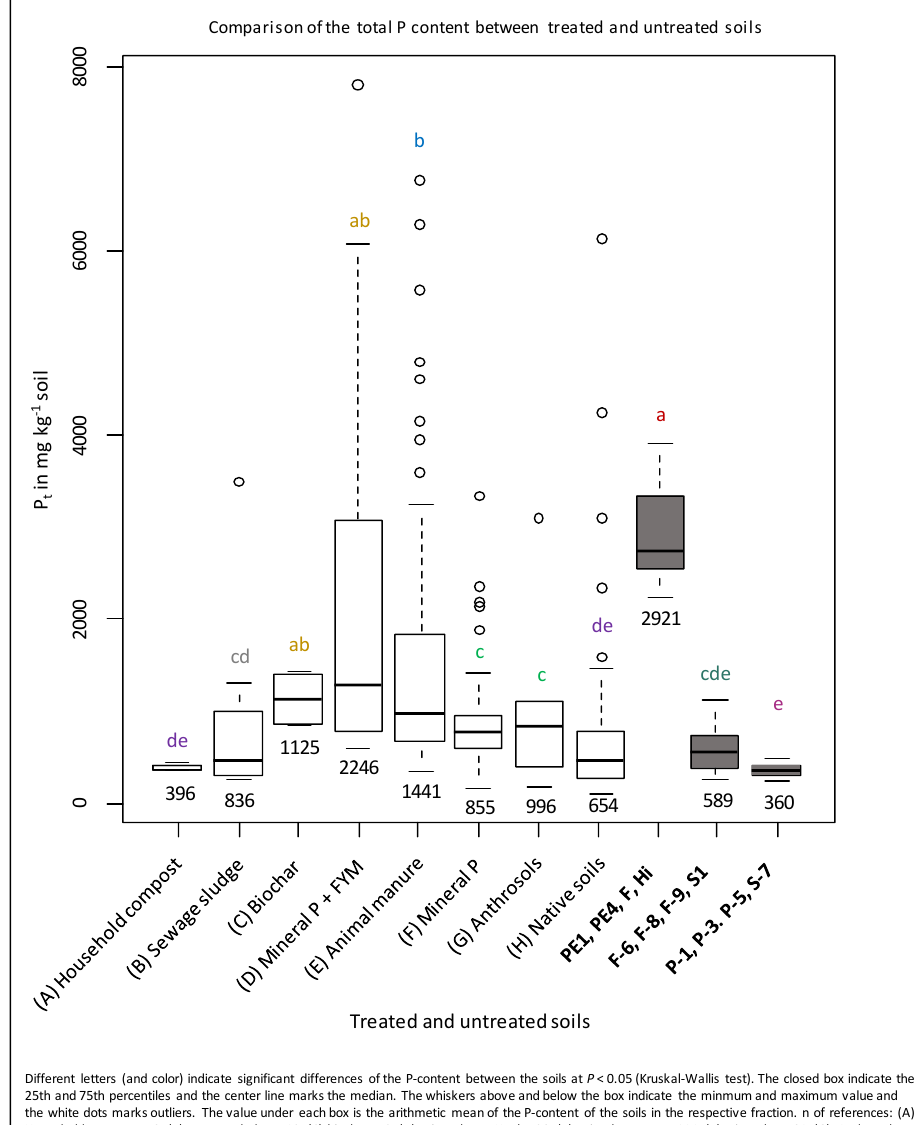
Different letters (and color) indicate significant differences ofthe P-content between the soils at P < 0.05 (Kruskal-Wallis test). The closed box indicate the 25th and75th percentiles and the centerline marksthe median. The whiskers aboveandbelow the box indicate the minmumand maximum valueand the white dots marksoutliers. The valueunder eachbox is the arithmetic meanof theP-content of the soils in the respective fraction. n of references: (A) Household compost = 3; (B) sewagesludge = 12; (C) biochar = 8; (D) mineralP + FYM* = 20; (E) animalmanure = 114; (F) mineral P = 64; (G) Anthrosols = 8; (H) native soils = 110. * Farmyardmanure (mixture of e.g. cattle, swine, poultry manure orstraw).